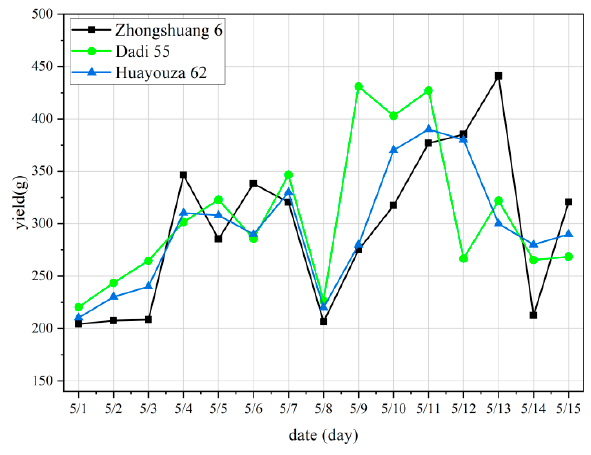
Figure 1. Daily yield change of rapeseed over 15 days.